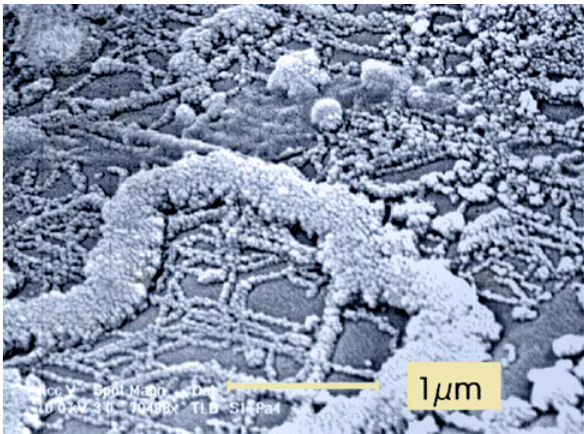
Figure 25. At 10 times greater magnification the polymeric silica globules on one of the non-striated faces of the quartz crystal in the Waitara Sinter are seen to have been deposited in more random pattern. Without the alignment of ‘steps’ the polymeric silica glo- bules (“little balls”) have been deposited in a wide variety in sizes (from Newton 12 ,